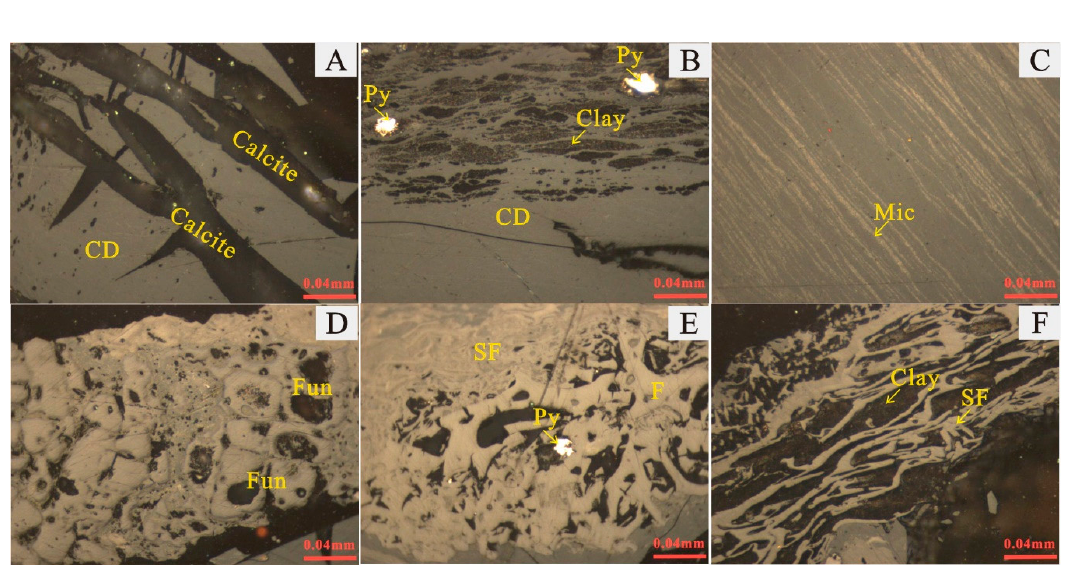
Table 2. The maceral contents of the coal samples from Dongpo Mine determined using optical microscopy (Vol. %; on a mineral-free basis).